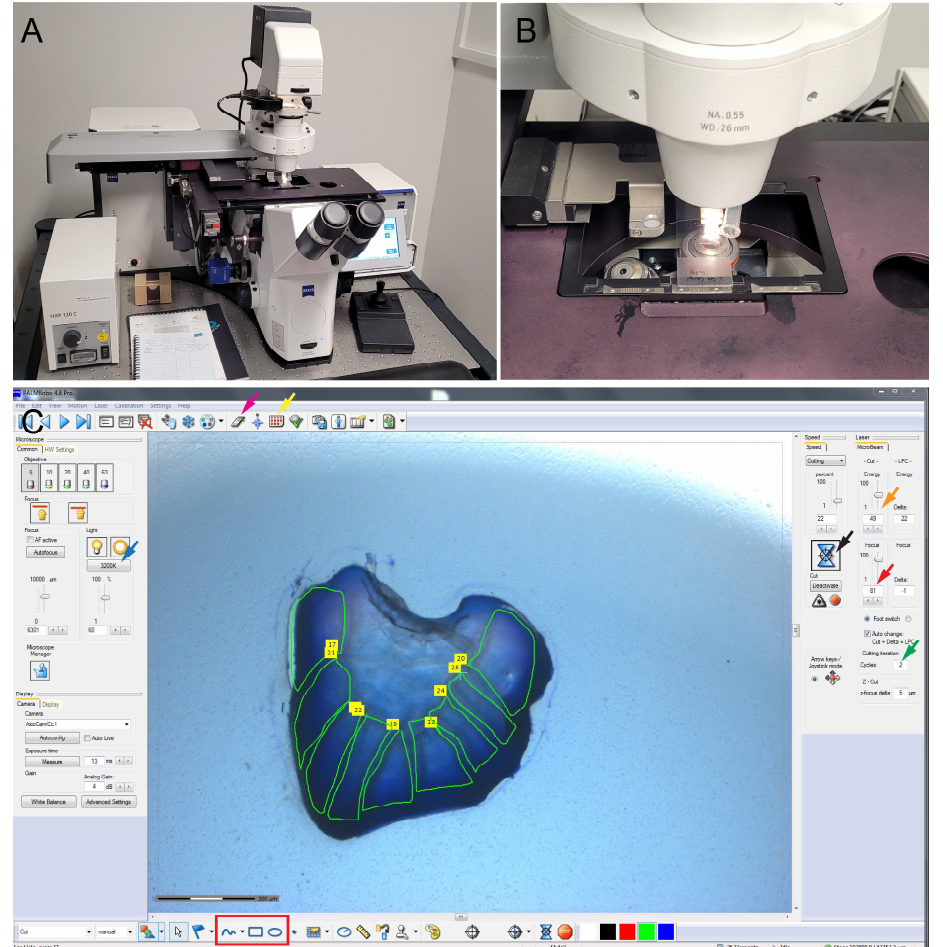
Figure 2. Zeiss PALM microbeam-laser microdissection microscope and PALMRobo 4.8 Pro set- tings for laser microdissection of Bicyclus anynana larval and pupal wings . ( A ) Zeiss PALM microbeam-laser microdissection microscope. ( B ) A closeup of the mounted slide on the microscope. ( C ) Settings used for laser microdissection of the larval and pupal wing tissues. Magenta arrow: slide holder control; yellow arrow: collection cap control; orange arrow: laser energy; red arrow: laser focus; green arrow: number of laser cutting cycles; blue arrow: intensity for the backlight; and red box: tools for selecting the sections for microdissection. Table 2. Settings for the PALMRobo 4.8 pro software for the dissection of butterfly larval and pupal wing tissues. Sl.